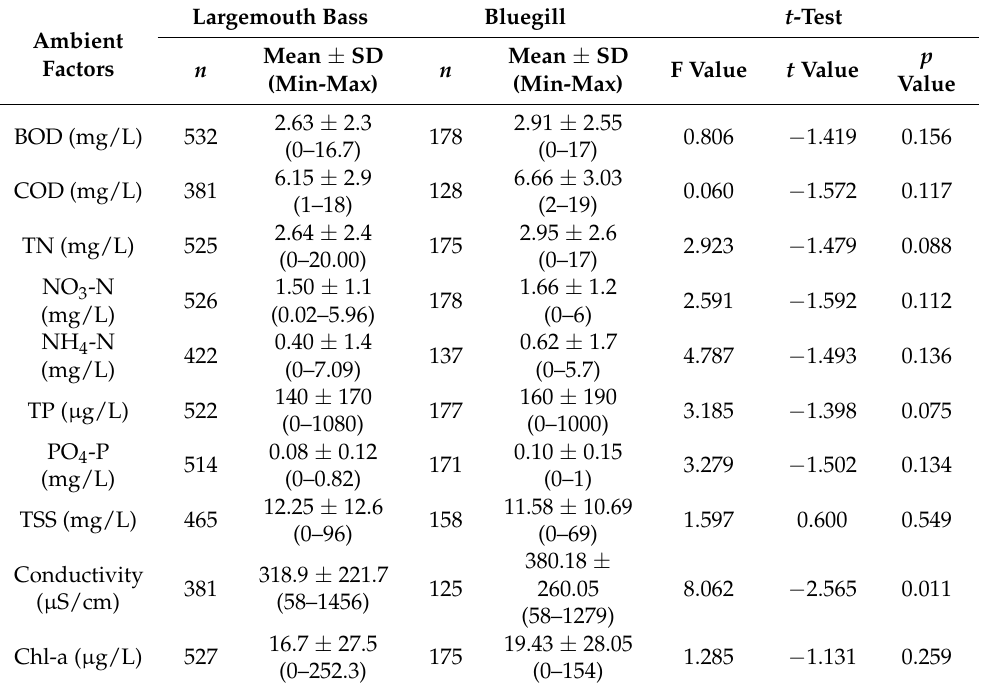
Table 2. Chemical gradients and tolerance of largemouth bass ( Micropterus salmoides ) and bluegill ( Lepomis macrochirus ) populations and independent-samples t -test